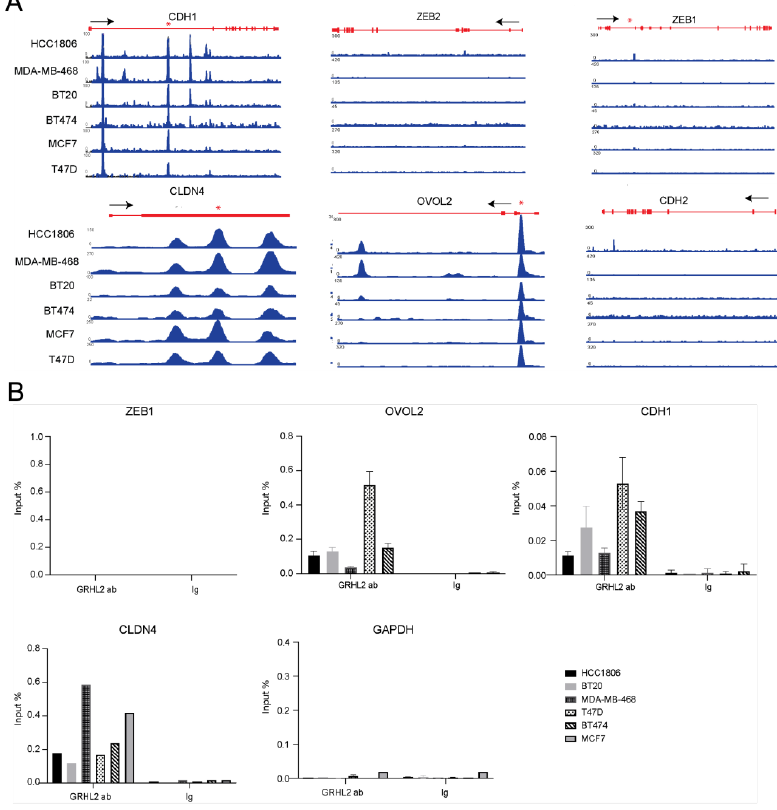
Figure 5. Occupation of EMT related genes by GRHL2. ( A ) ChIP tracks for the indicated genes in luminal and basal A breast cancer cell lines. The track height is scaled from 0 to the indicated num- ber. The locus with its exon/intron structure is presented in red. ( B ) ChIP-qPCR validation of pres- ence and absence of GRHL2 binding sites identified by ChIP-seq. Location of the qPCR primer set in the locus is indicated by * in ( A ). Graphs represent the efficiency of indicated genomic DNA co- precipitation with anti-GRHL2 Ab or IgG control Ab. Signals for IgG control and GRHL2 antibody pulldown samples were normalized to input DNA and are presented as % input with SEM from 3 technical replicates with the exception of CLDN4 due to depletion of input material. Data were sta- tistically analyzed by t-test and * indicates p < 0.05. In addition to the direct binding of regulators of EMT, GRHL2 may regulate EMT indirectly. In luminal (MCF7) and basal A cells (HCC1806), GRHL2 knockout, but not control sgRNA, triggered a reduction in E-cadherin protein expression (Figure 6A). How- ever, the induction of mesenchymal markers, Vimentin and N-cadherin, was only ob- served in HCC1806 cells. These Western blot results were confirmed using confocal im- munofluorescence microscopy. E-cadherin was expressed at cell-cell junctions and in the cy- toplasm in HCC1806 and MCF7 cells and GRHL2 knockout led to reduced expression (Figure 6B,C). A concomitant gain of Vimentin expression was only observed in HCC1806 cells. These results showed that direct binding of GRHL2 to EMT-related genes is shared be- tween luminal and basal A cells, but GRHL2 depletion triggers several aspects associated with an EMT in HCC1806, whereas only reduction of E-cadherin is observed in MCF7, which may be in agreement with the enhanced migration observed in GRHL2-depleted HCC1806 but not MCF7 cells.